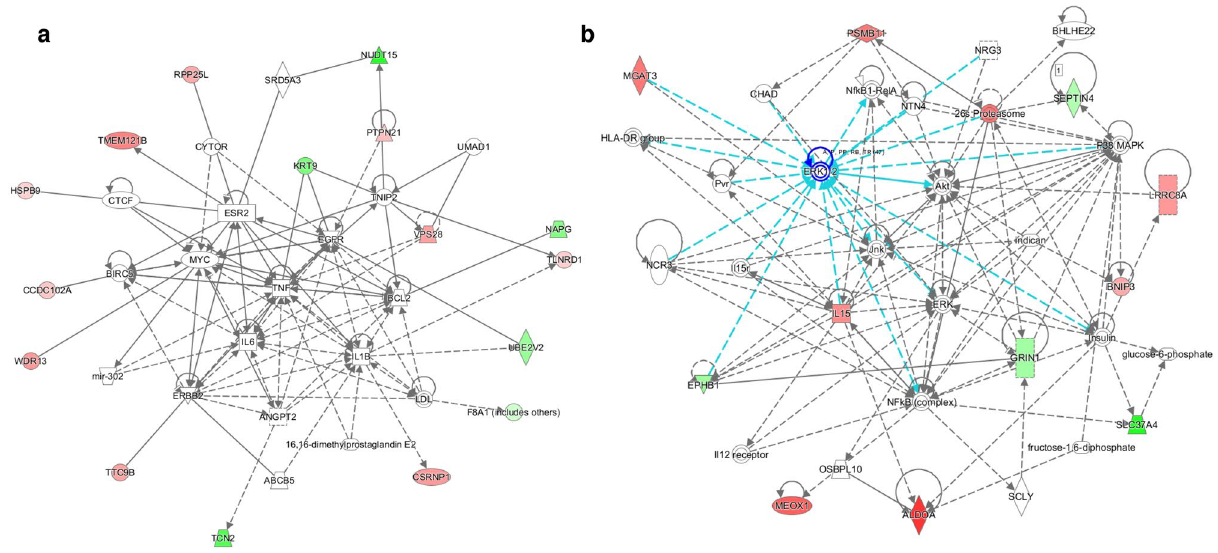
Figure 3. The top-scoring regulatory networks identified using IPA software connecting DMPs between ( a ) high and low heat stressed samples was Cell-to-cell Signalling and Interaction, Amino Acid Metabolism, Cell Death and Survival , and between ( b ) high and low control samples was Immunological Disease, Neurological Disease, Skeletal and Muscular Disorders . Genes that had hypermethylated and hypomethylated promoter regions in high samples are green and red respectively. Solid and dashed lines between genes represent known direct and indirect gene interactions, respectively. The shapes of the nodes reflect the functional class of each gene product: transcriptional regulator (horizontal ellipse), enzyme (vertical rhombus), cytokine (square), phosphatase (triangle), kinase (inverted triangle), complex/other (circle), transporter (trapezoid), and enzyme (rhombus). The networks were generated through the use of IPA (QIAGEN Inc., https:// www. qiage nbioi nform atics. com/ produ cts/ ingen uityp athway- analy sis).